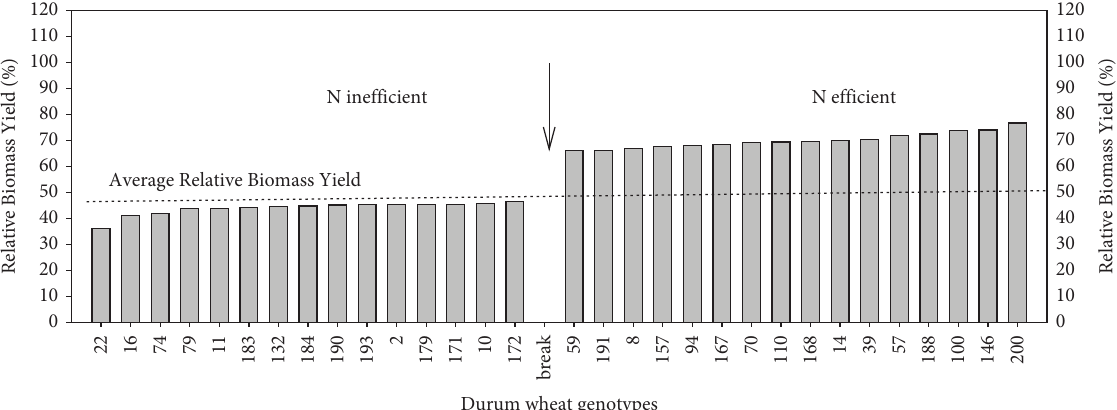
Figure 4: Categorization of N-efcient and inefcient genotypes based on relative biomass yield (only the 15 most extreme genotypes from each efcient and inefcient category were mentioned in the abovementioned fgure due to limited space to accommodate all; the break is the demarcation between N-efcient and inefcient